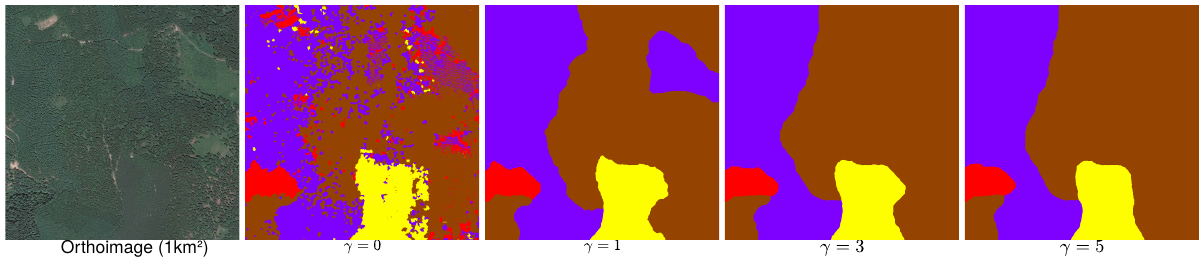
Figure 8. Effect of the smoothing parameter γ on the segmentation. See Figure 5 for the colour codes.